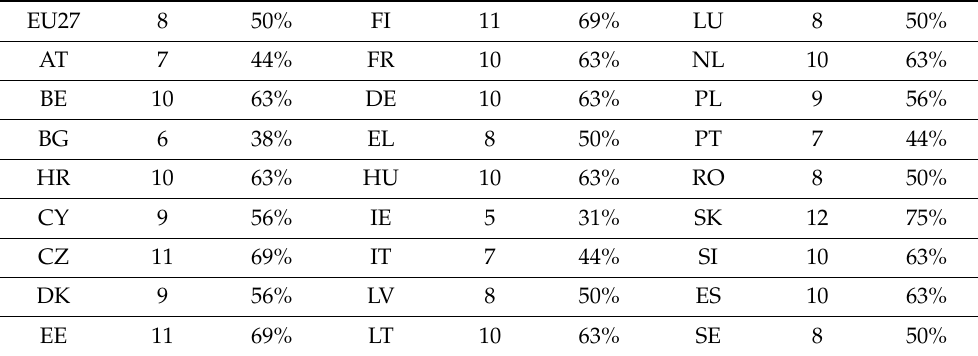
Table 3. Occurrence of periods when country’s DRs had similar sign to its